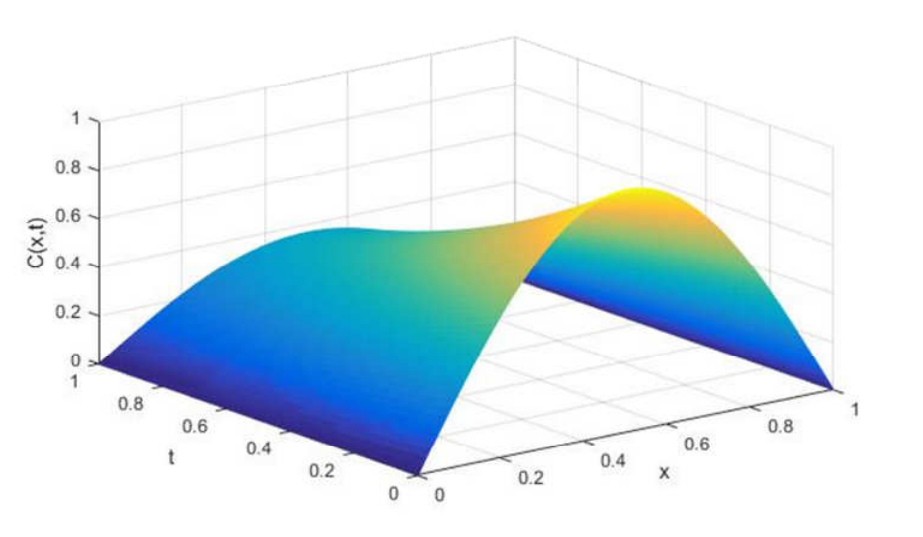
Figure 4. Diffusion process of the initial concentration for (cid:21) (cid:2) 1/(cid:23) (cid:2) , (cid:10) (cid:2) 0.01 (cid:12) and (cid:13)(cid:14) (cid:2) 0.0001 (cid:15) in Problem 2 . Problem 3 [14,10] Advection-diffusion process on a finite line